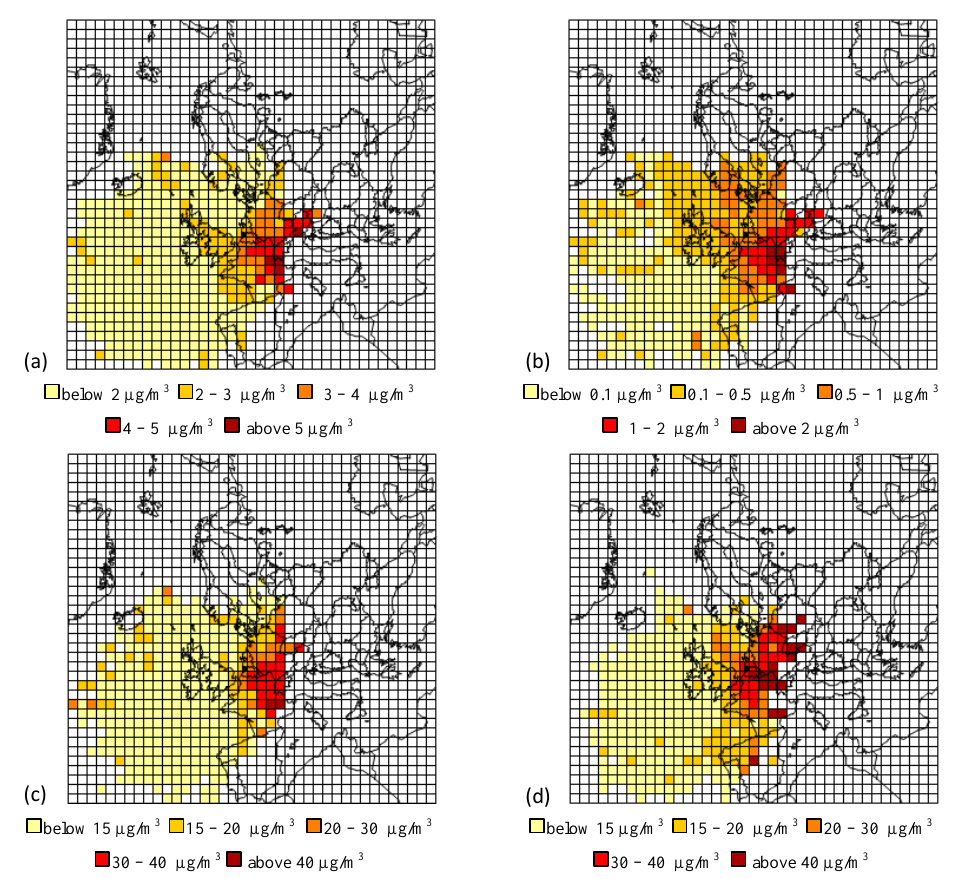
Fig. 4. Concentration field map of (a) Secondary OC, (b) EC, (c) gravimetric PM 10 , (d) gravimetric PM 2 . 5 sulphate. Wagstroma and Pandis (2011) explained these